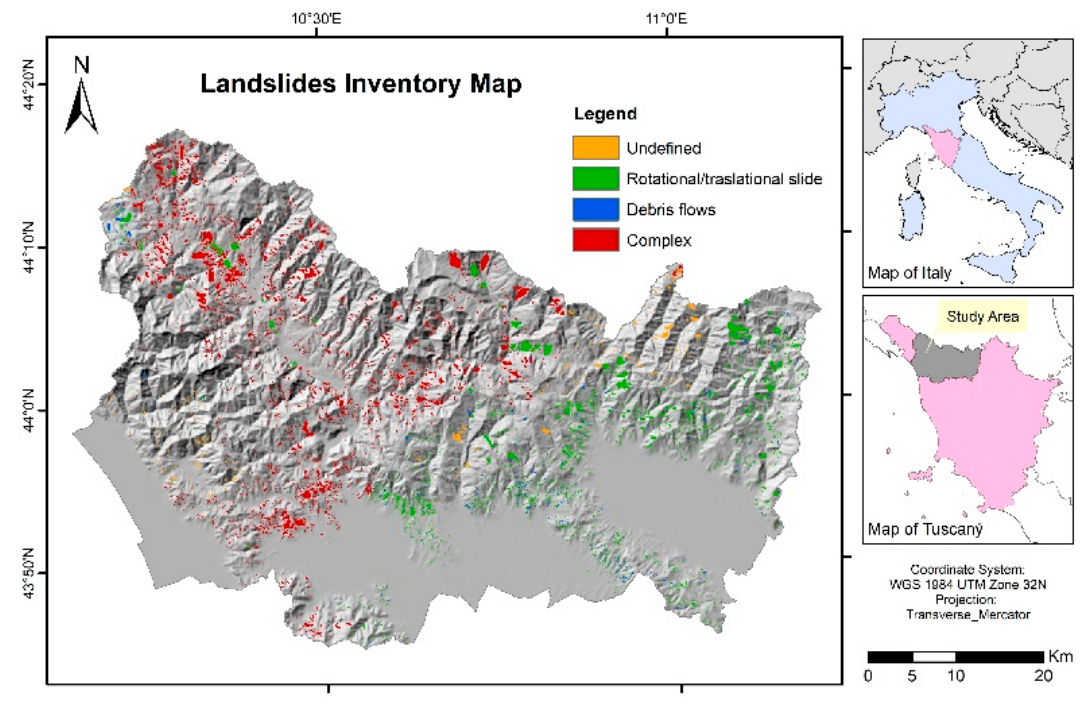
Figure 2. Landslides inventory map.